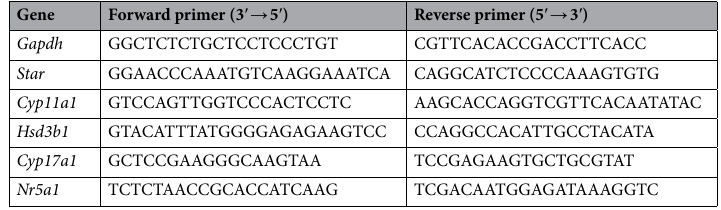
Table 1. Sequences of primers used for